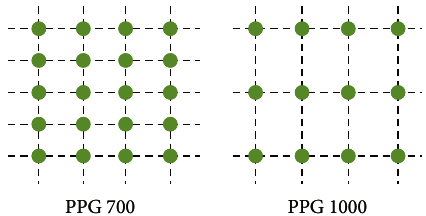
Scheme 1: A schematic diagram of crosslinking densities of PU(PPG 700) and PU(PPG